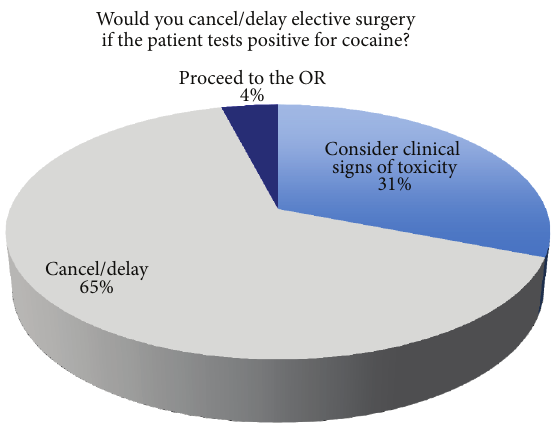
Figure 2: Percentages of anesthesia departments responses to a positive cocaine urine drug